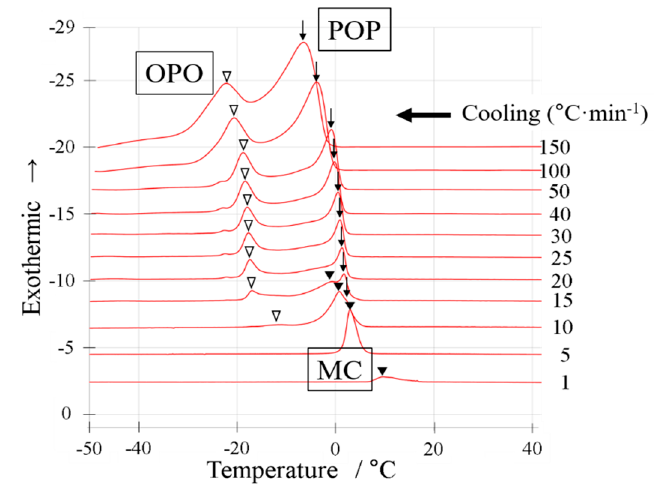
Figure 4. DSC cooling thermograms with a binary mixture of OPO/POP = 6/4. The x-axis shows temperature. The y-axis shows normalized exothermic heat flow. The thermograms overlay at cooling rate of 1~150 °C·min − 1 from bottom to top. The open triangles indicate OPO crystallization. The arrows indicate POP crystallization. The closed triangles indicate MC crystallization.